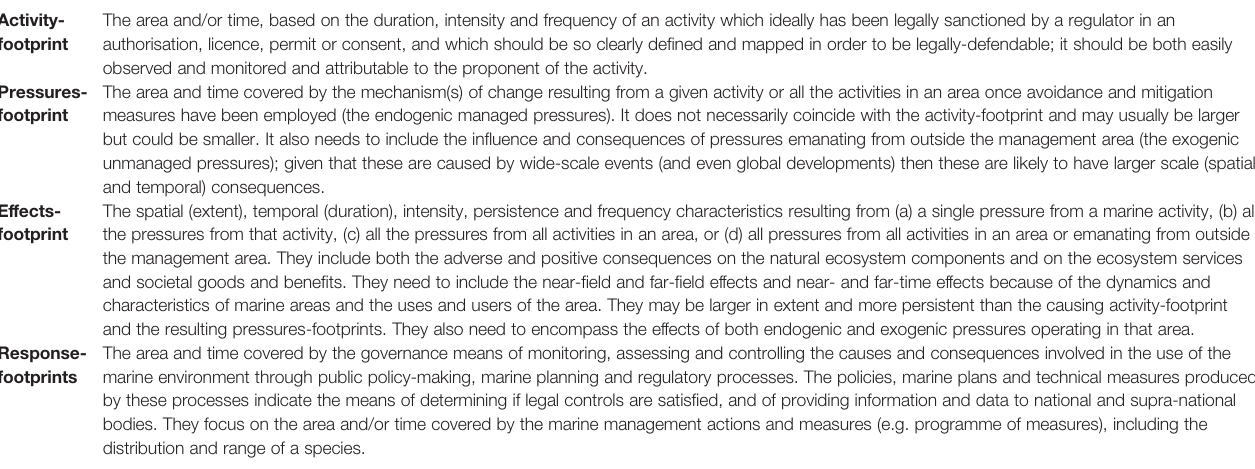
TABLE 1 | De fi nitions for activity, pressures and effects footprints (adapted from Elliott et al.,